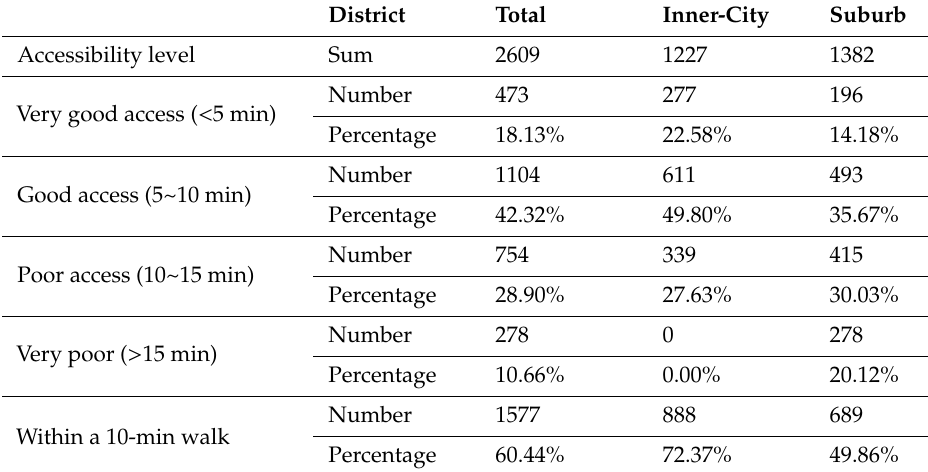
Table 3. Statistics results of accessibility in